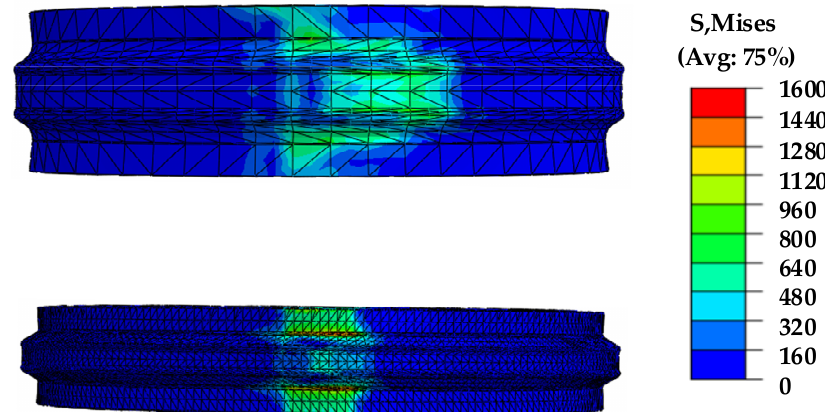
Figure 11. Result of structural simulation of the rolls of the 2nd RDF process.